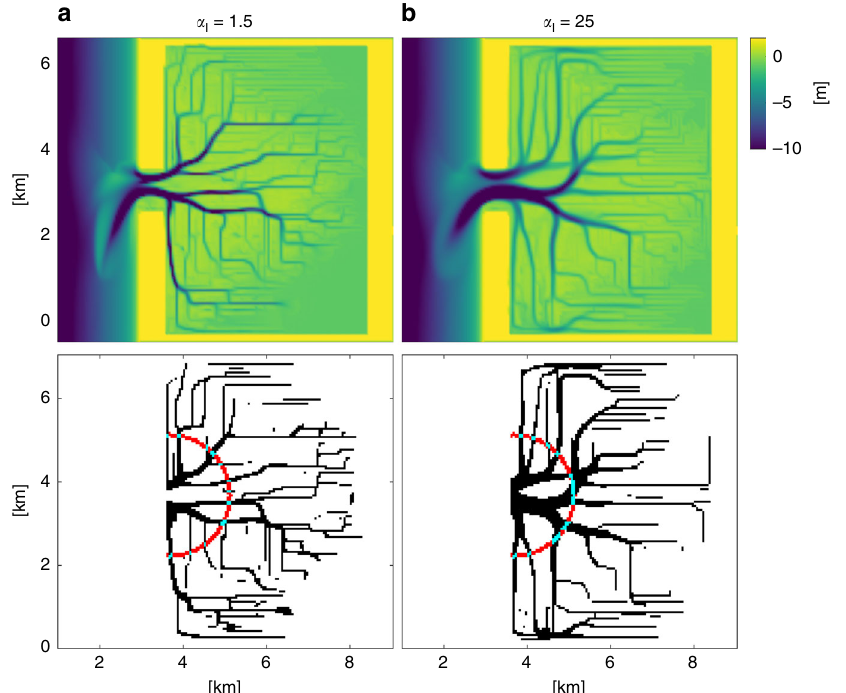
of a 1.5 (default) I